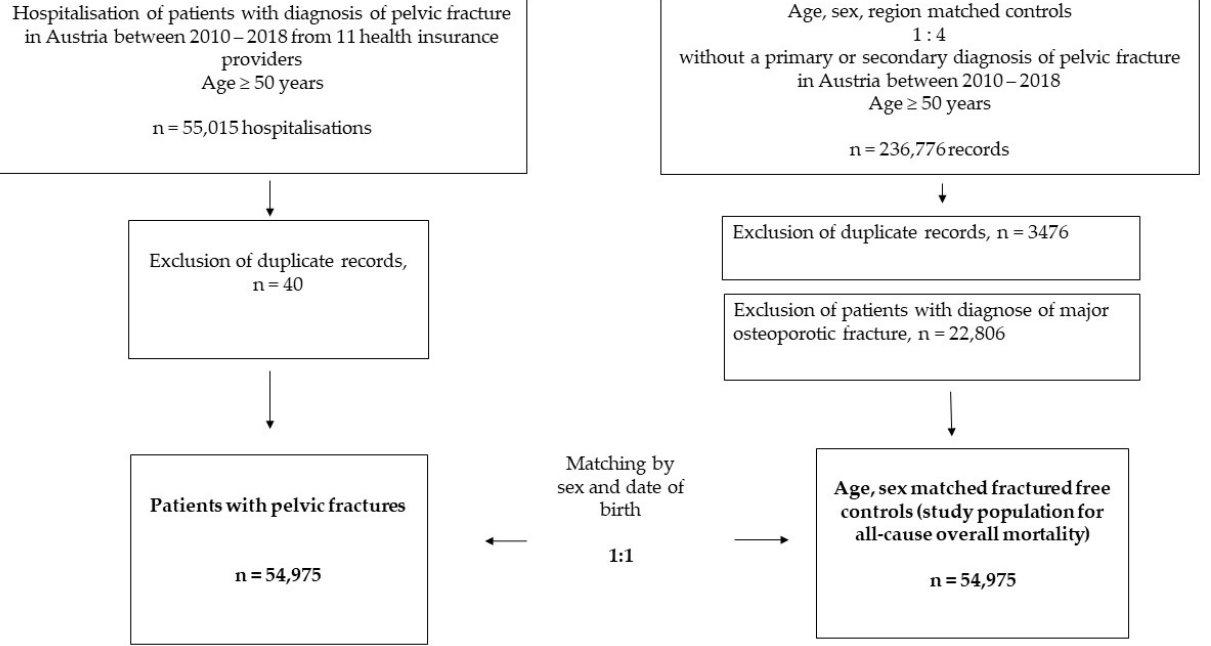
Figure 1. Flowchart of the study population.